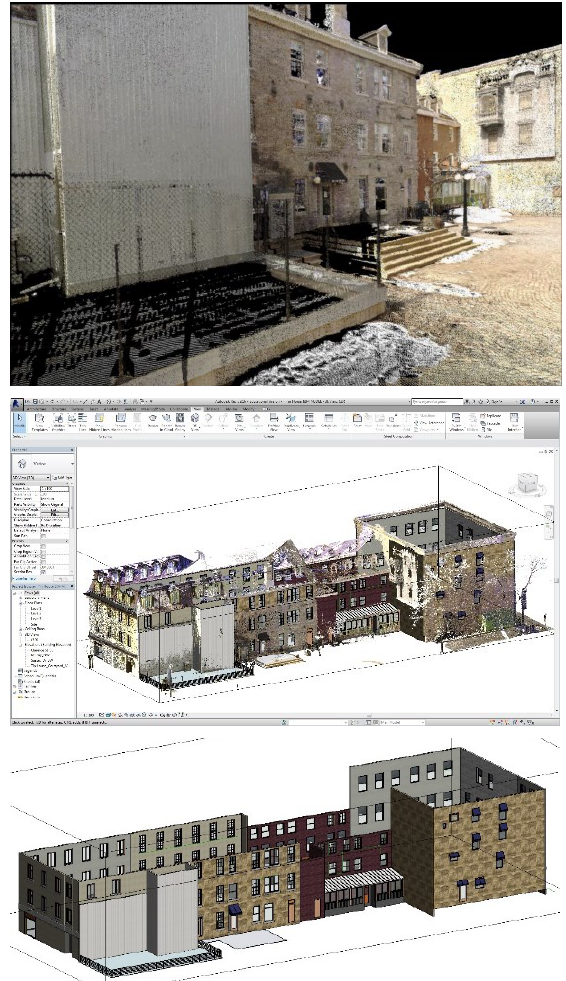
Figure 6: Walk-through on the point cloud. BIM model partially constructed out of the point